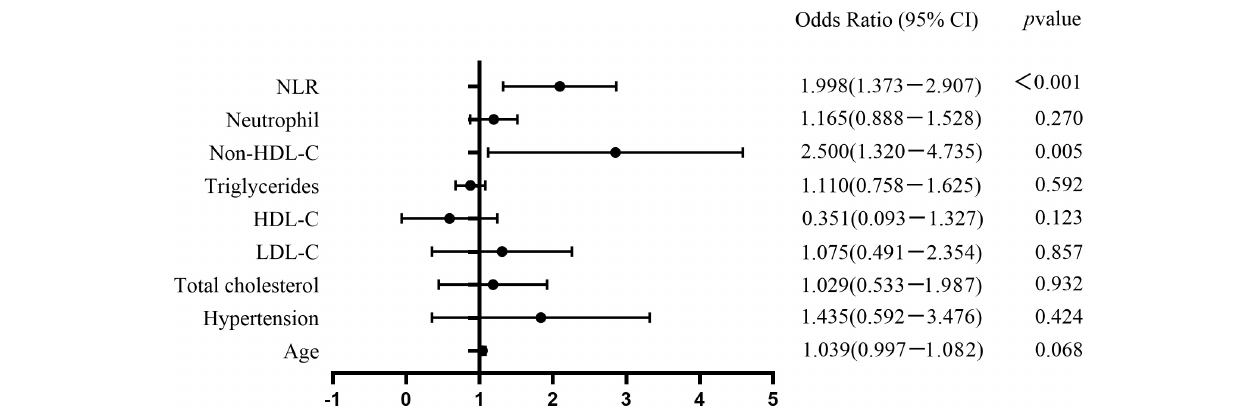
FIGURE 1 | Forest plots show the comparison of risk factors for coronary artery vulnerable plaques in T2DM patients. Non-HDL-C (OR 2.500, 95%CI: 1.32–4.735) and NLR (OR 1.998, 95%CI: 1.373–2.907) were independent risk factors for coronary artery vulnerable plaques.